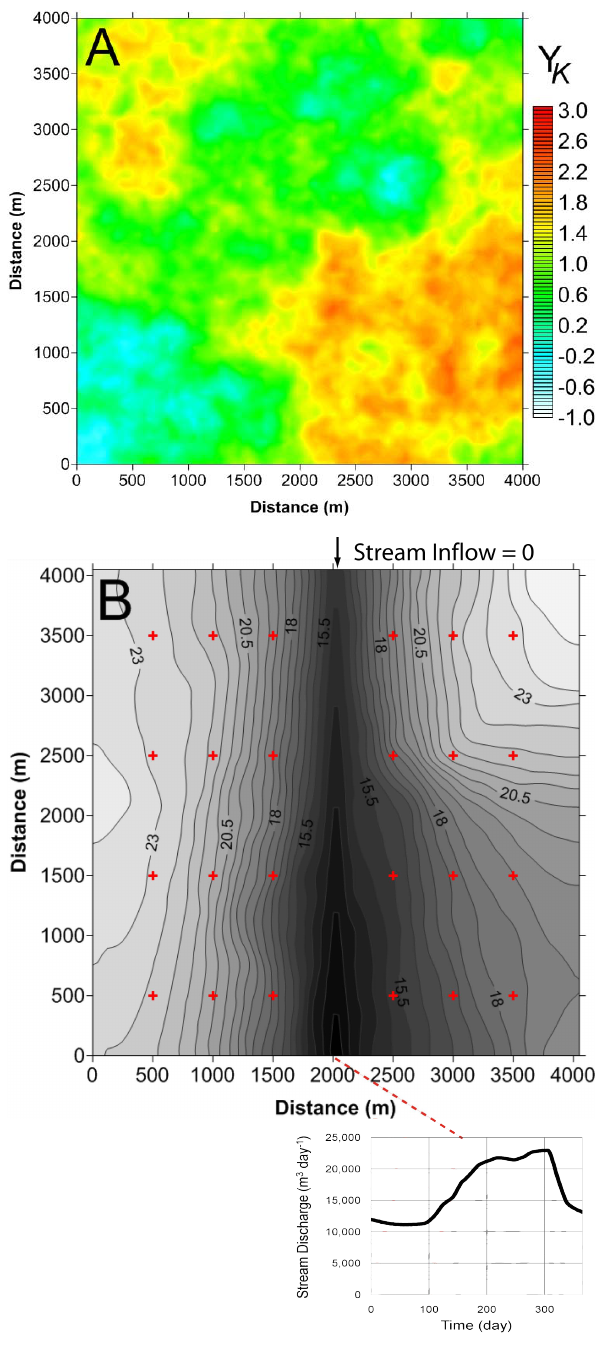
Fig. 5. (A) Reference field of true Y K and (B) corresponding WT field at time=365 days as calculated by CATHY. In (B) , red crosses indicate the location of 24 observation wells. The streamflow at the outlet cell during the 365-day simulation is shown in the